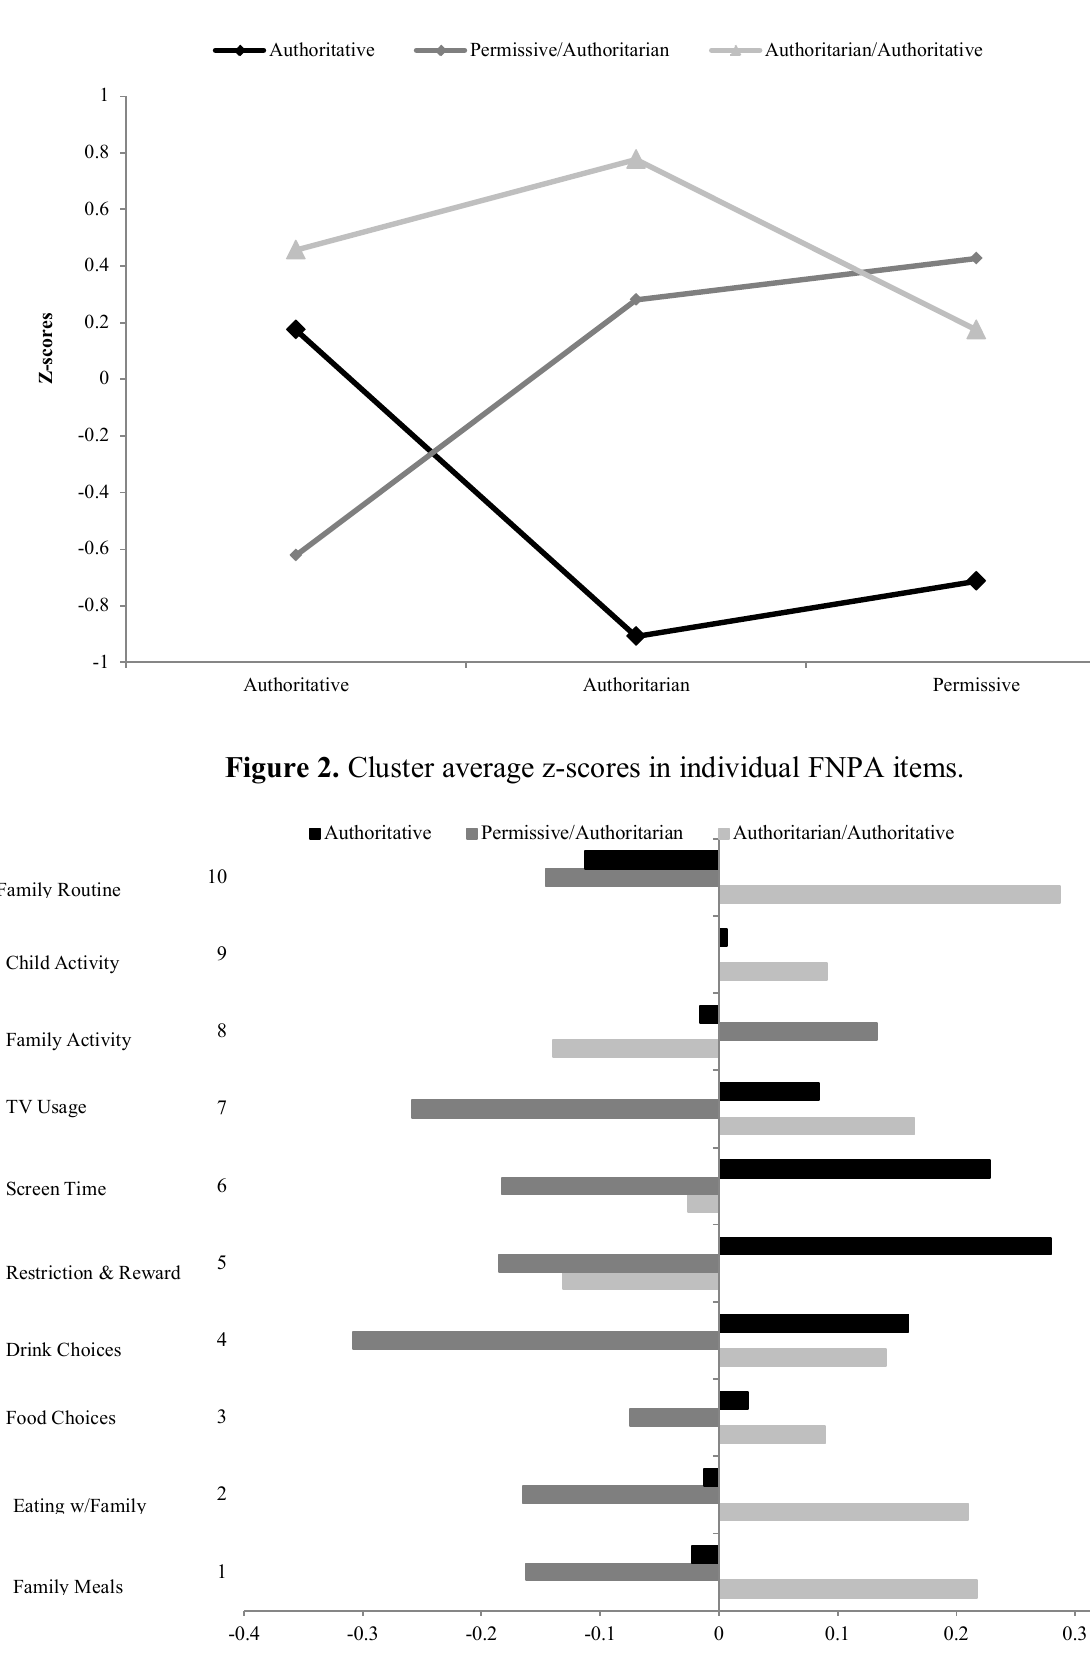
Figure 1. Average Z-scores for the three-cluster parenting style.